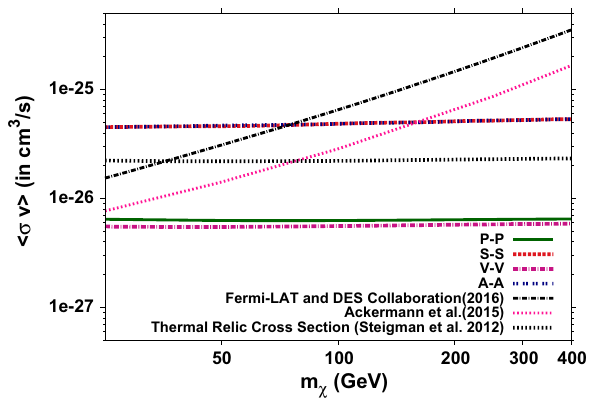
Fig. 3 The variation of the thermal averaged DM annihilation cross sections versus the leptophilic DM mass m χ . The cross sections are computed using the upper limit on Λ obtained from the relic density curves in Fig. 1 corresponding to the flavour-universal couplings for = α l = α l = α l = 1. These are compared DM with leptons α l PP SS VV AA with the median of the thermal averaged DM annihilation cross section derived from a combined analysis of the nominal target sample for the τ + τ − channel assuming a 100% branching fraction [19,20]